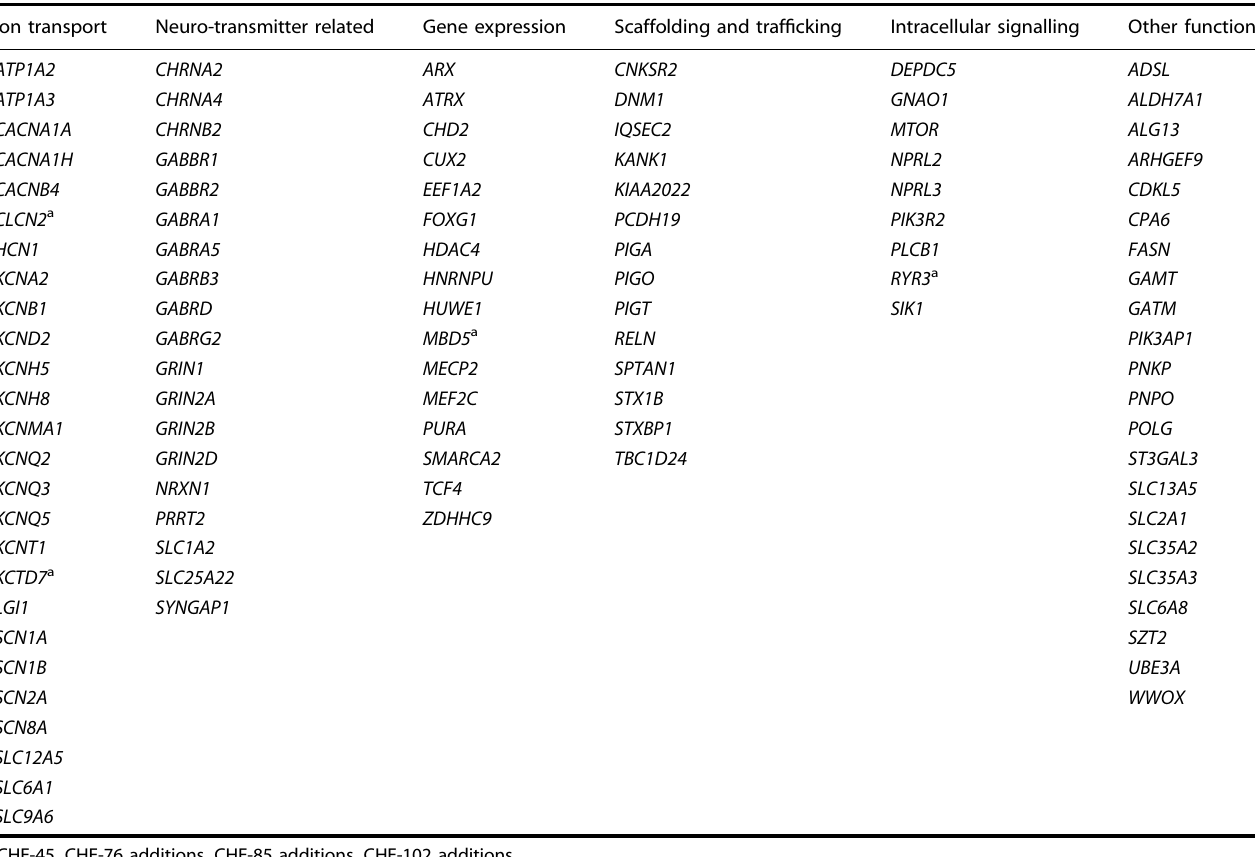
Table 6. Gene panels used in this study, categorized by gene